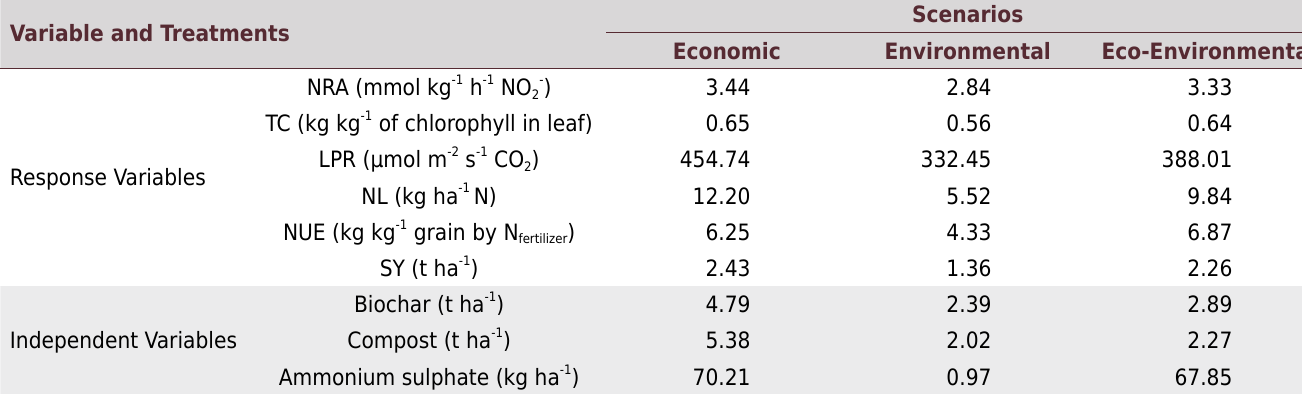
Table 3. Optimized value of kayu putih waste and nitrogen fertilizer applications for response variables Variable and Treatments